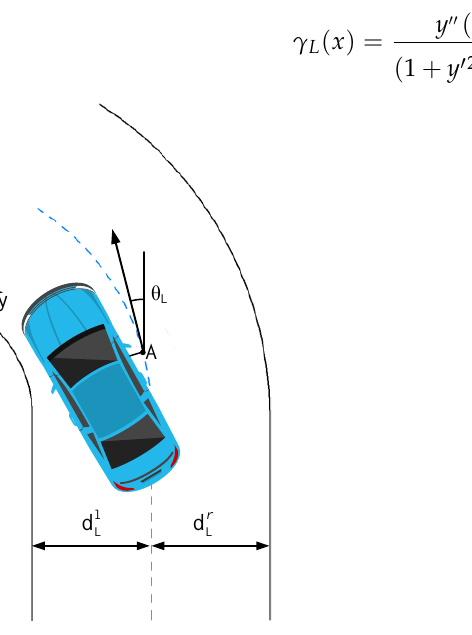
Figure 5. Lane centerline modeling.